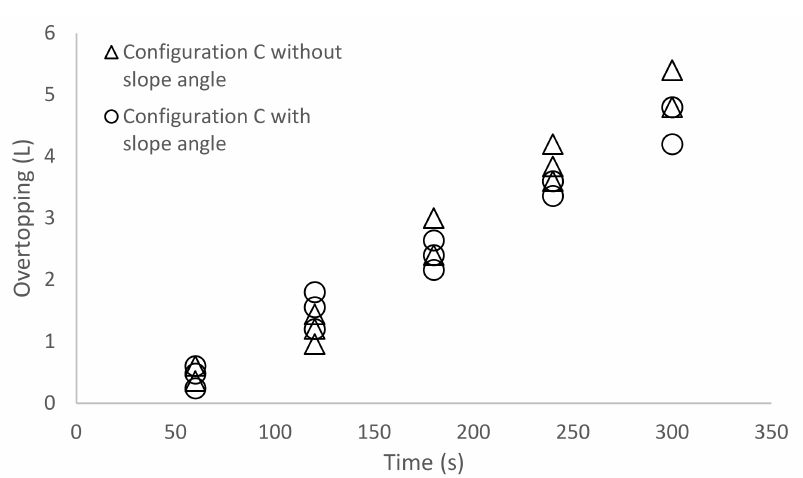
Figure13. PerformanceofConfigurationBwithandwithoutslopeangleforJONSWAPhydraulicconditions.